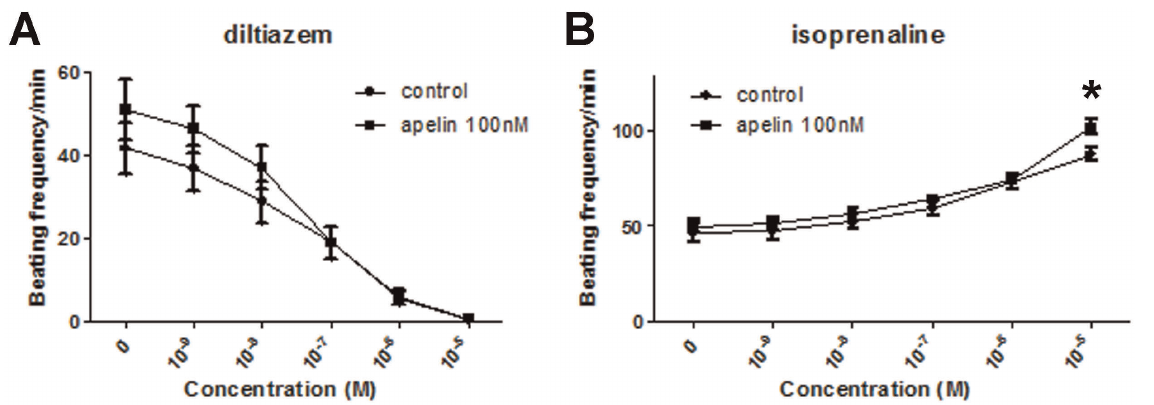
Figure 3. Pharmacologic response of mEBs. (A) Effect of diltiazem (calcium channel blocker) and (B) Isoprenaline ( b 1-adrenoreceptor agonist) on mESC-derived cardiomyocytes on day 14 of differentiation (*p , 0.05). Corresponding negative and positive chronotropy was observed for diltiazem and isoprenaline, respectively.